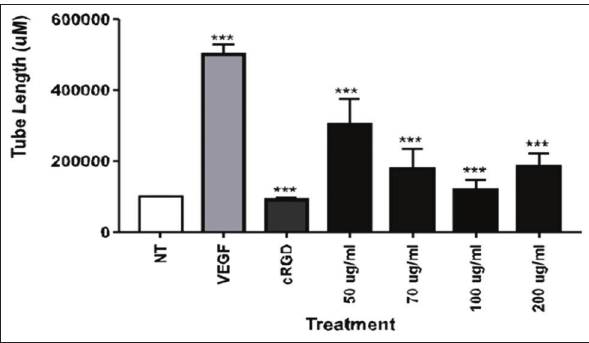
Figure-4: Ocimum sanctum (OS) ethanolic extract suppresses tube formation of human lung adenocarcinoma (A549) cells. OS ethanolic extract was give into the cells, and vascular endothelial growth factor was run as positive controls; meanwhile, cRGD was run as negative control. Tube formation was assessed by the use of a stage micrometer as calibrator. Data are given as mean±SD for n=3 independent experiments. Statistical analysis was performed using one- way analysis of variance followed by Tukey’s post hoc test as appropriate (****p<0.05=significant).